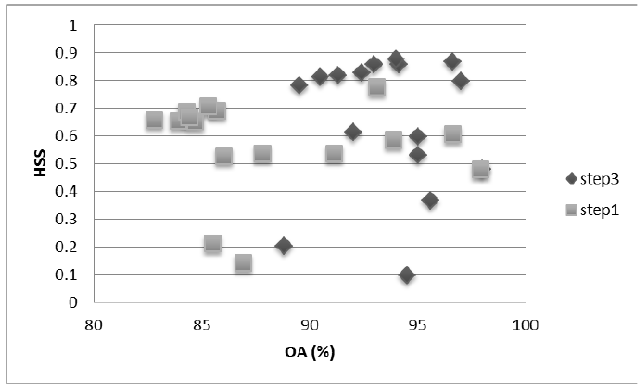
Figure 4. Comparison of overall accuracy (OA) and Heidke Skill Score (HSS) scores for masking levels identified as step 1 and step 3. The graph indicates that the increasing of the OA from step 1 to step 3 is found also in an increase of the HSS index.